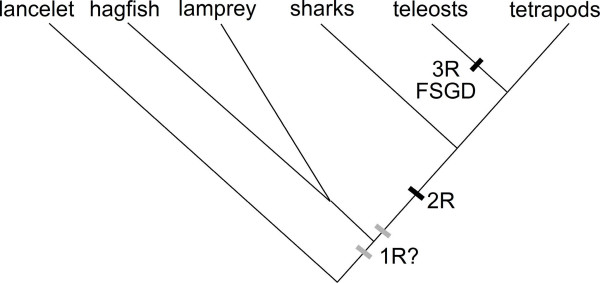
General overview of phylogenetic relationships among gnathostomes and the proposed phylogenetic timing of genome duplication events. Grey rectangles depict the possible position of the first genome duplication (1R); the black ones show the second genome duplication (2R), and fish-specific genome duplication (FSGD or 3R).